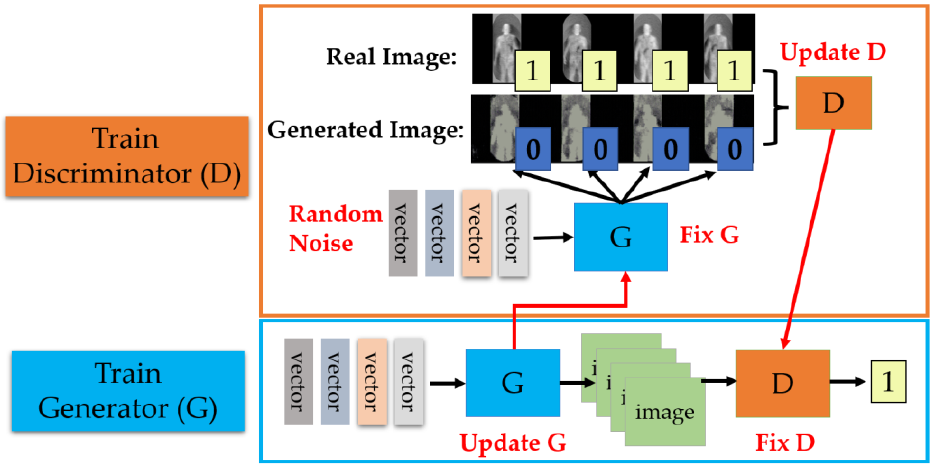
Figure 1. Overall framework of Res-WGAN-GP.